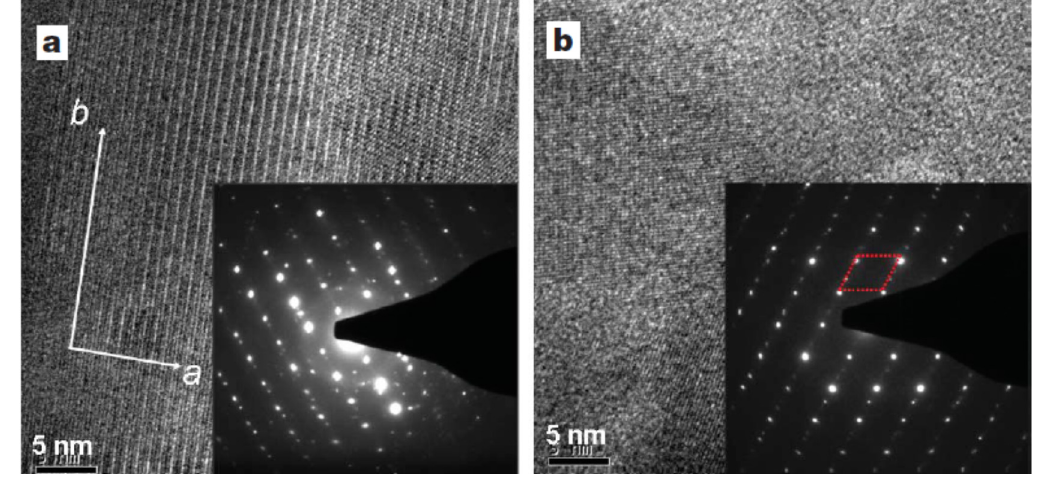
Figure 7. High-resolution TEM images and electron diffraction patterns of bulk crystalline In 4 Se 2.78 ( δ = 0.22) in ( a ) the ab -plane and ( b ) the bc -plane. Reproduced with permission from Nature publishing Group, 2009